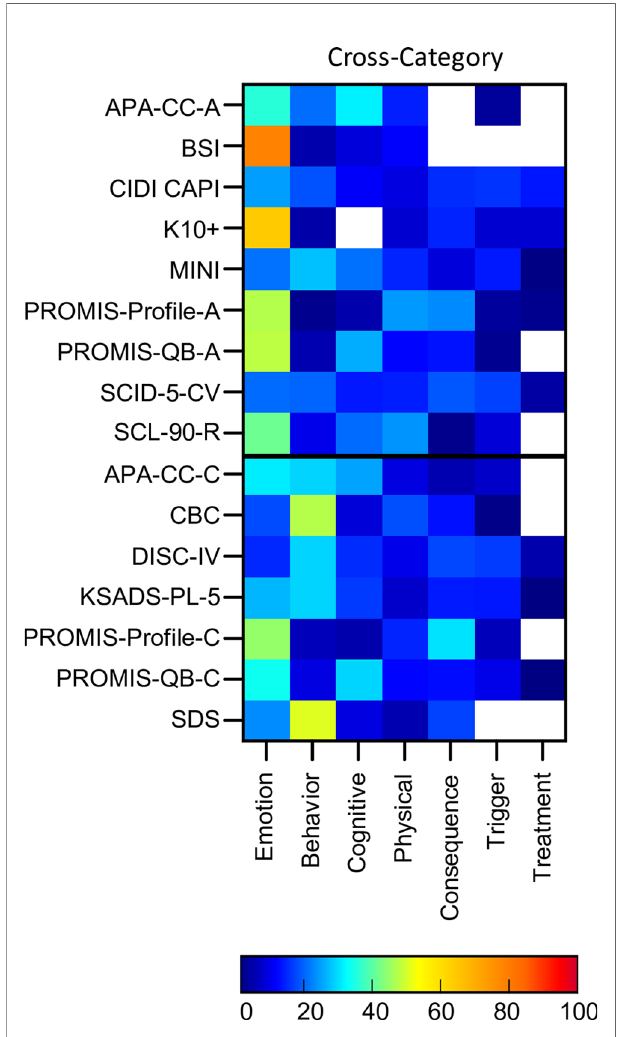
FIGURE 8 | Proportion of symptom themes. Proportion of symptom themes (%) across cross disorder assessment tools. Black line denotes delineation between adult (top) and pediatric (bottom) tools. See Supplementary Table 5 for a list of